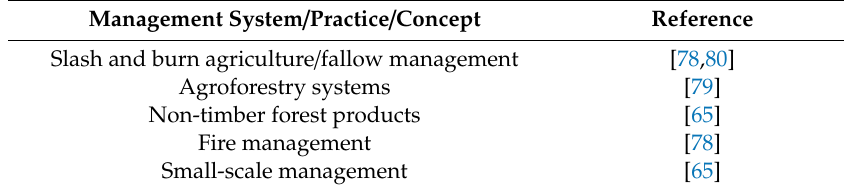
Table 2. Concepts and forest management practices associated with traditional ecological knowledge reviewed in Mexican forest laws and codes (modified from